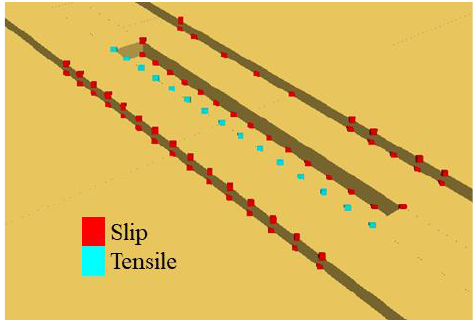
Figure 13. The yield state of the rock-concrete interface.